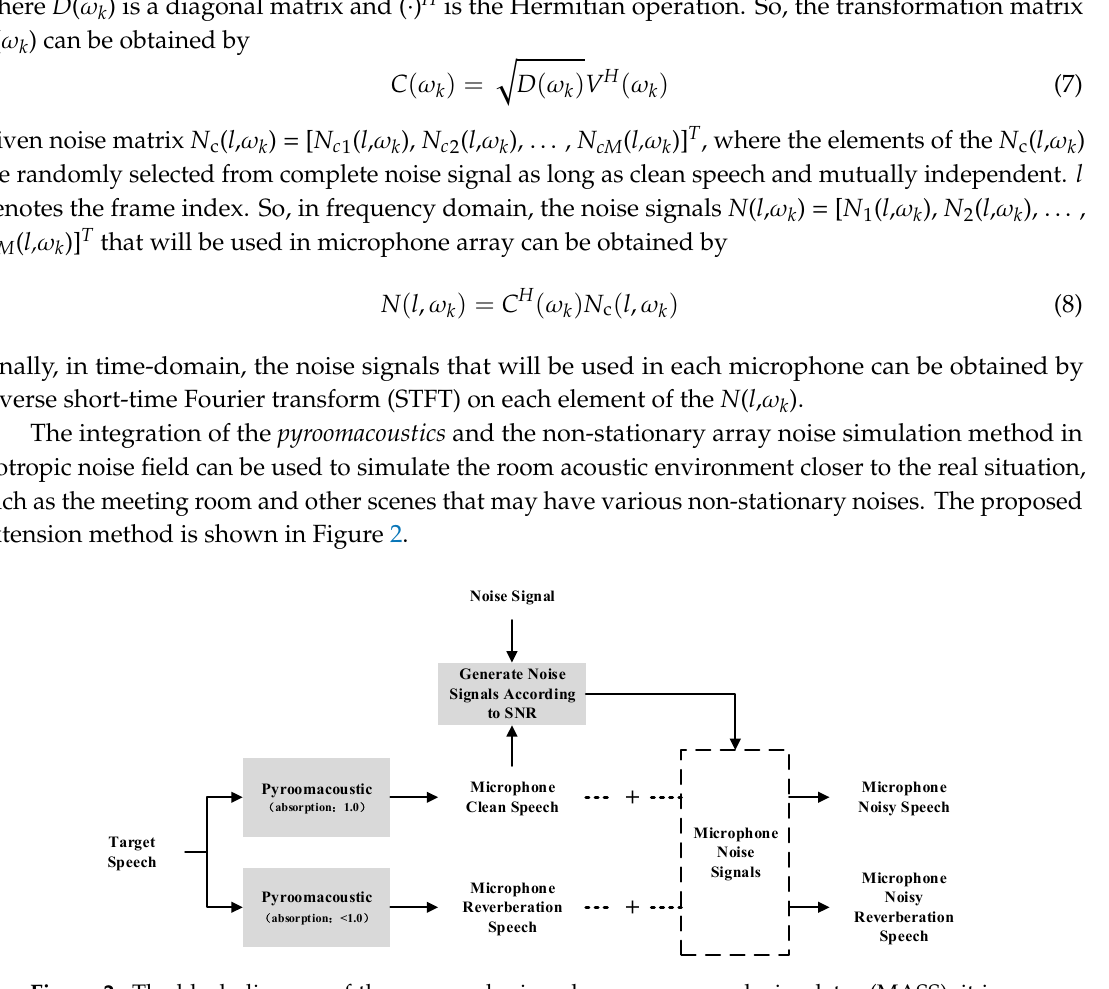
Figure 2. The block diagram of the proposed microphone array speech simulator (MASS); it is an extension of the pyroomacoustics .